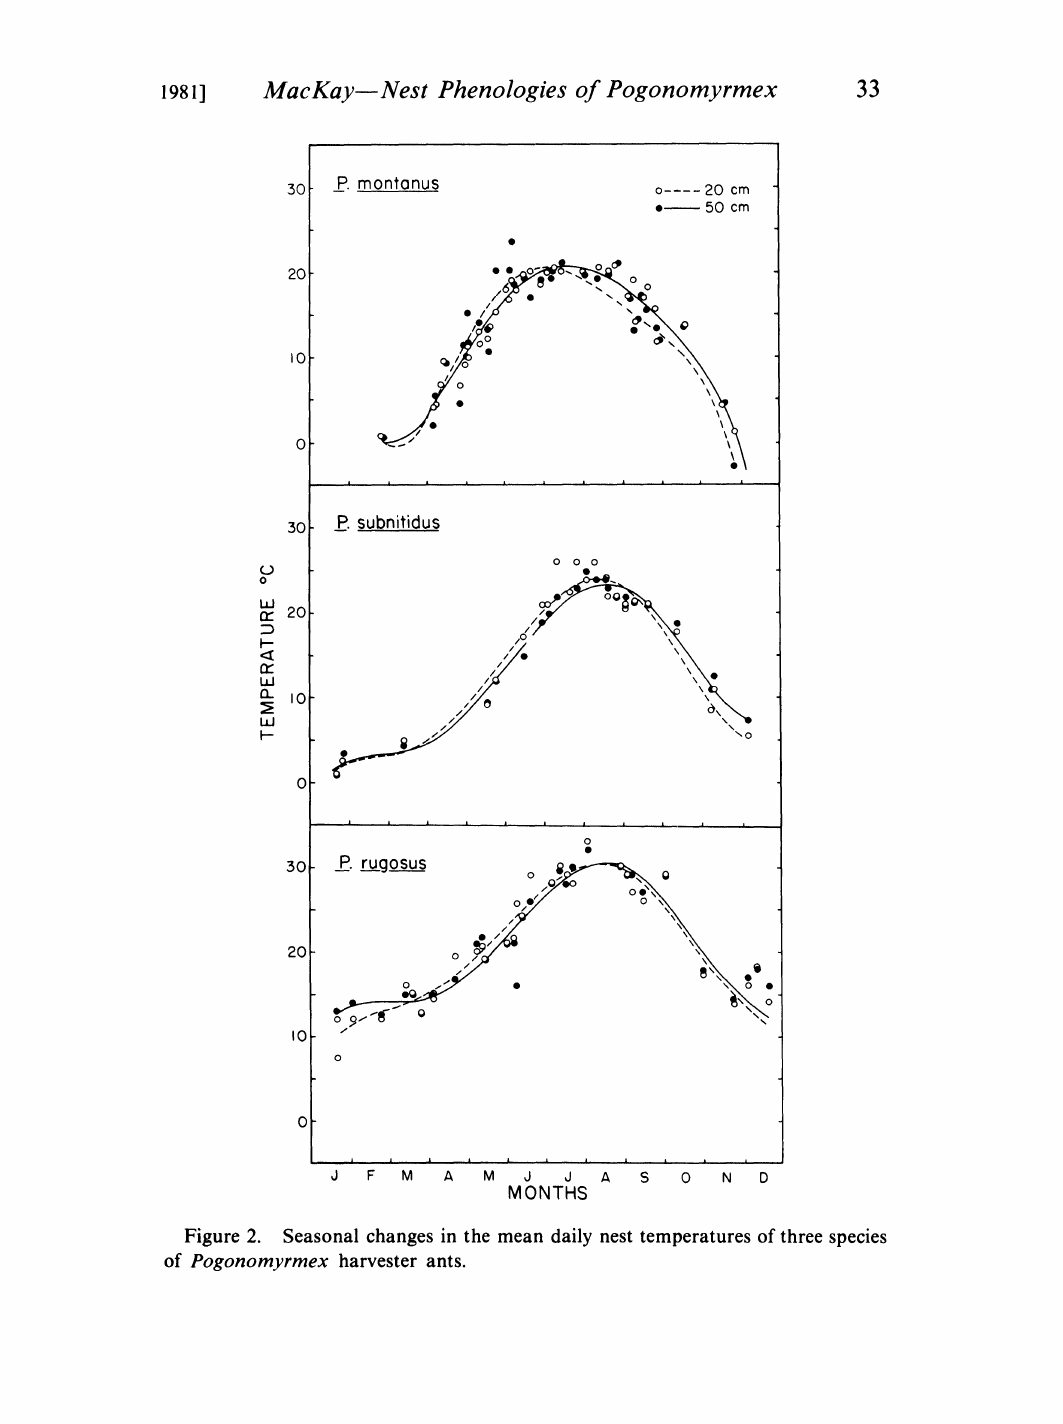
Figure 2. Seasonal changes in the mean daily nest temperatures of three species of Pogonomyrmex harvester